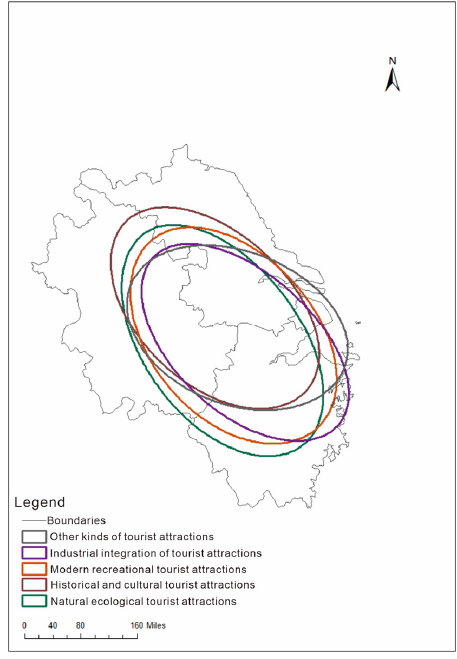
Figure 3. Standard deviation ellipse of the five types of tourist attractions. The X -axis of the ellipse represents the spatial distribution direction of tourist attrac- tions, and the shorter the X -axis is, the less obvious the direction is. According to the order